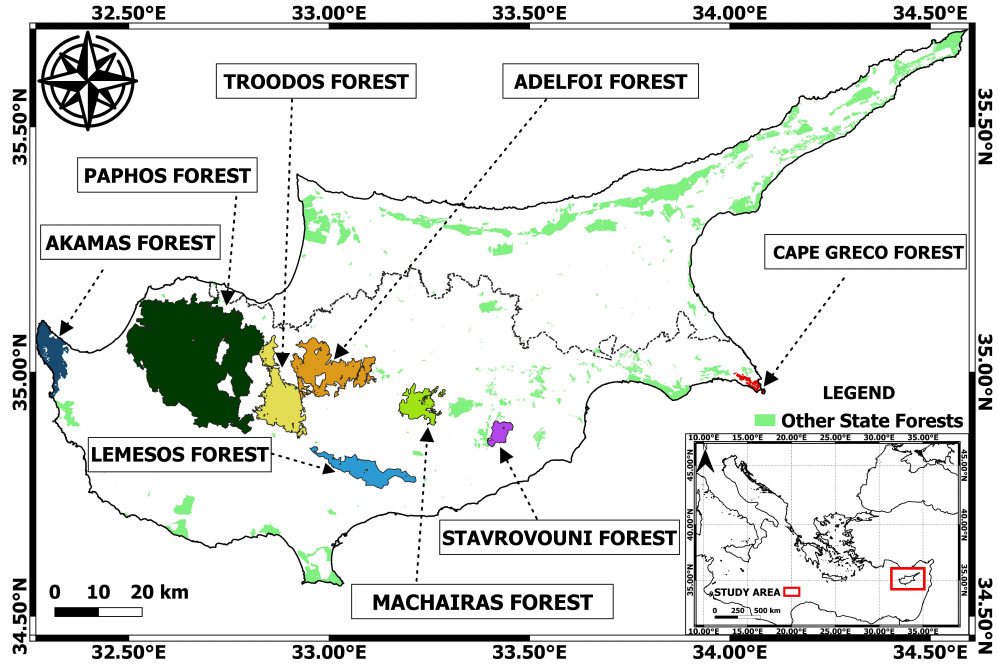
Figure 1. Study Area—Location and names of forests in Cyprus according to the Department of